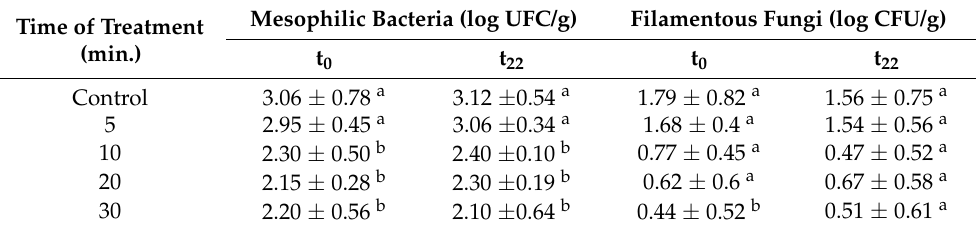
Table 2. Total mesophilic aerobic bacteria and filamentous fungi count naturally present in sundried tomatoes immediately (t 0 ) and at 22 (t 22 ) days after ACP treatment. Mesophilic Bacteria (log Time of Treatment (min.)